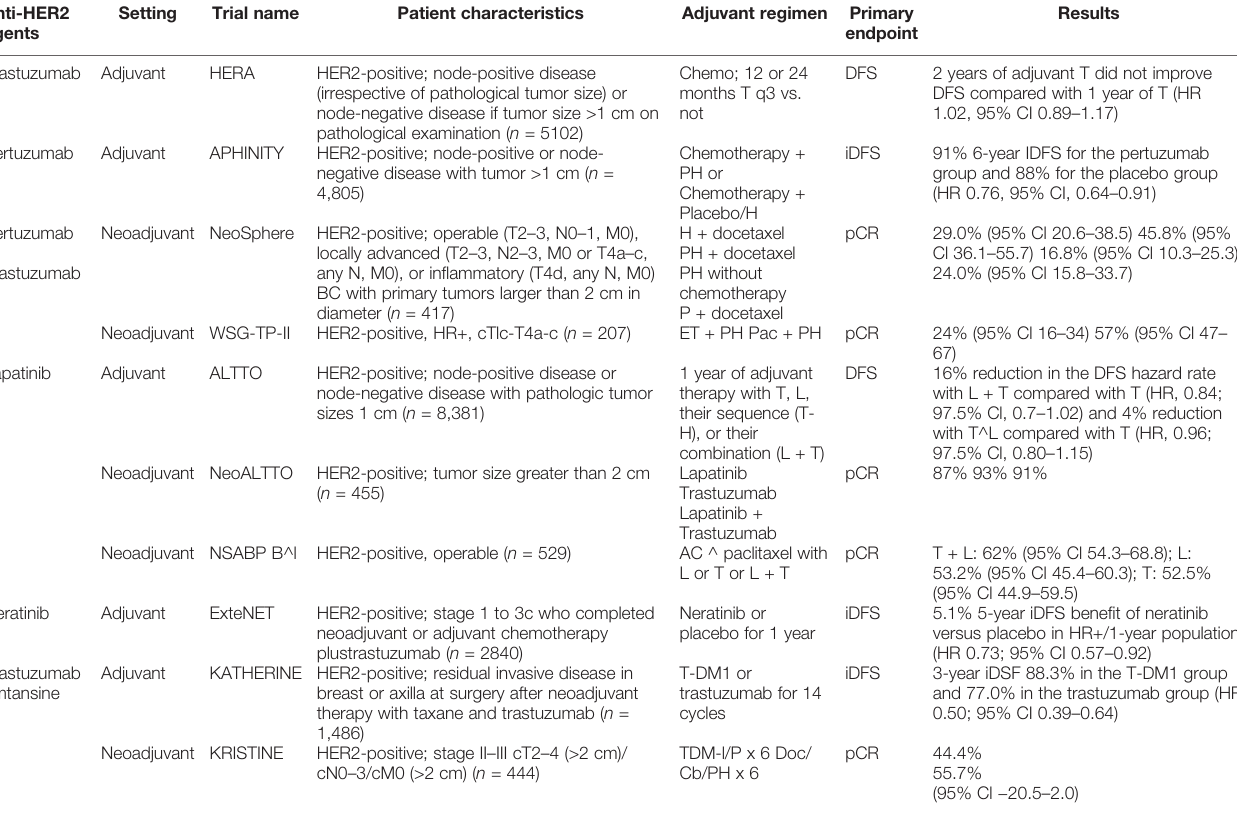
TABLE 1 | Summary of the principal clinical trials involving anti-HER2 agents for early-stage HER2-positive BC. Anti-HER2 agents